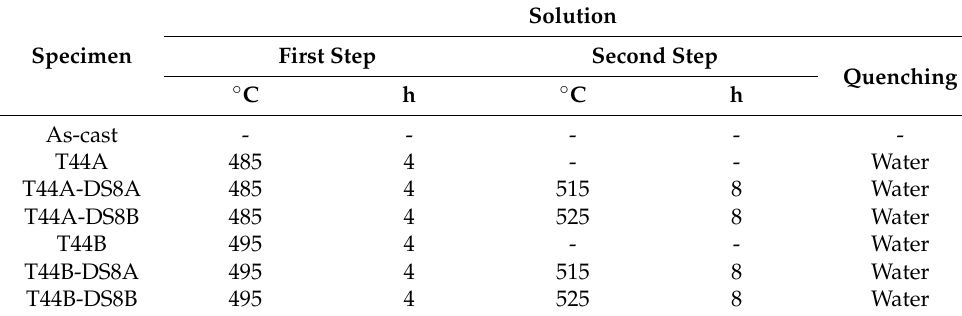
Table 1. Schedule of the double-solution heat